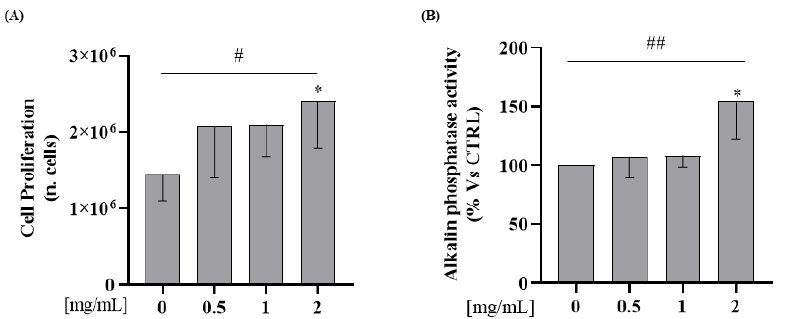
Figure 4. WP increases cellular proliferation and alkaline phosphatase activities on Saos-2 cells. Semi-confluent cultures of human osteoblast-like cells (Saos-2) were incubated with WP 0.5,1 and 2 mg/mL for 24 h. ( A ) Cell proliferation was determined by counting the number of cells in each well. ( B ) ALP activity was measured by pNPP method. Data are represented as mean ± SD. Statistical analysis: Student’s t-test vs. 0: * p < 0.05 (Student’s t-test); # p < 0.05, ## p < 0.01 (Test for linear